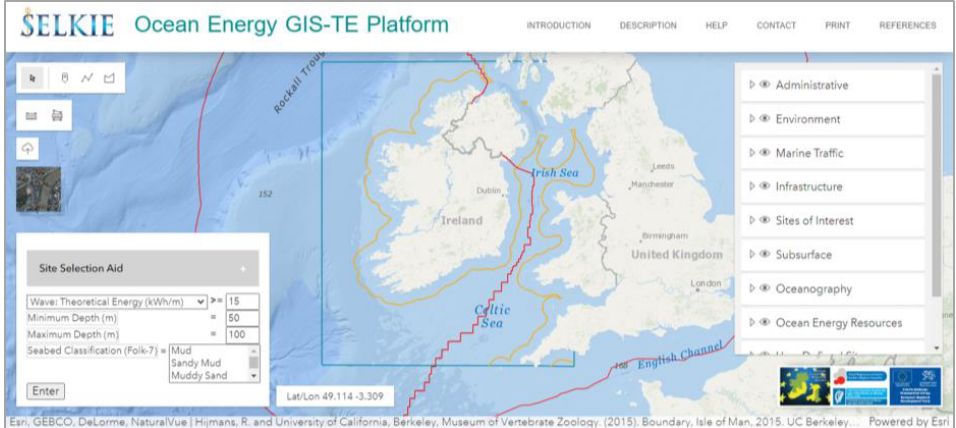
Figure 6. The CWA tool interface as it appears once opened by the user.